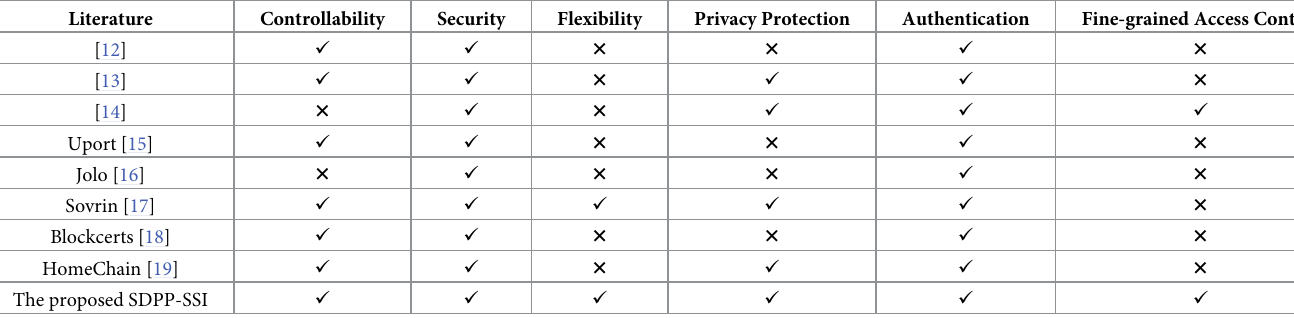
Table 7. Comparison and analysis of the related work